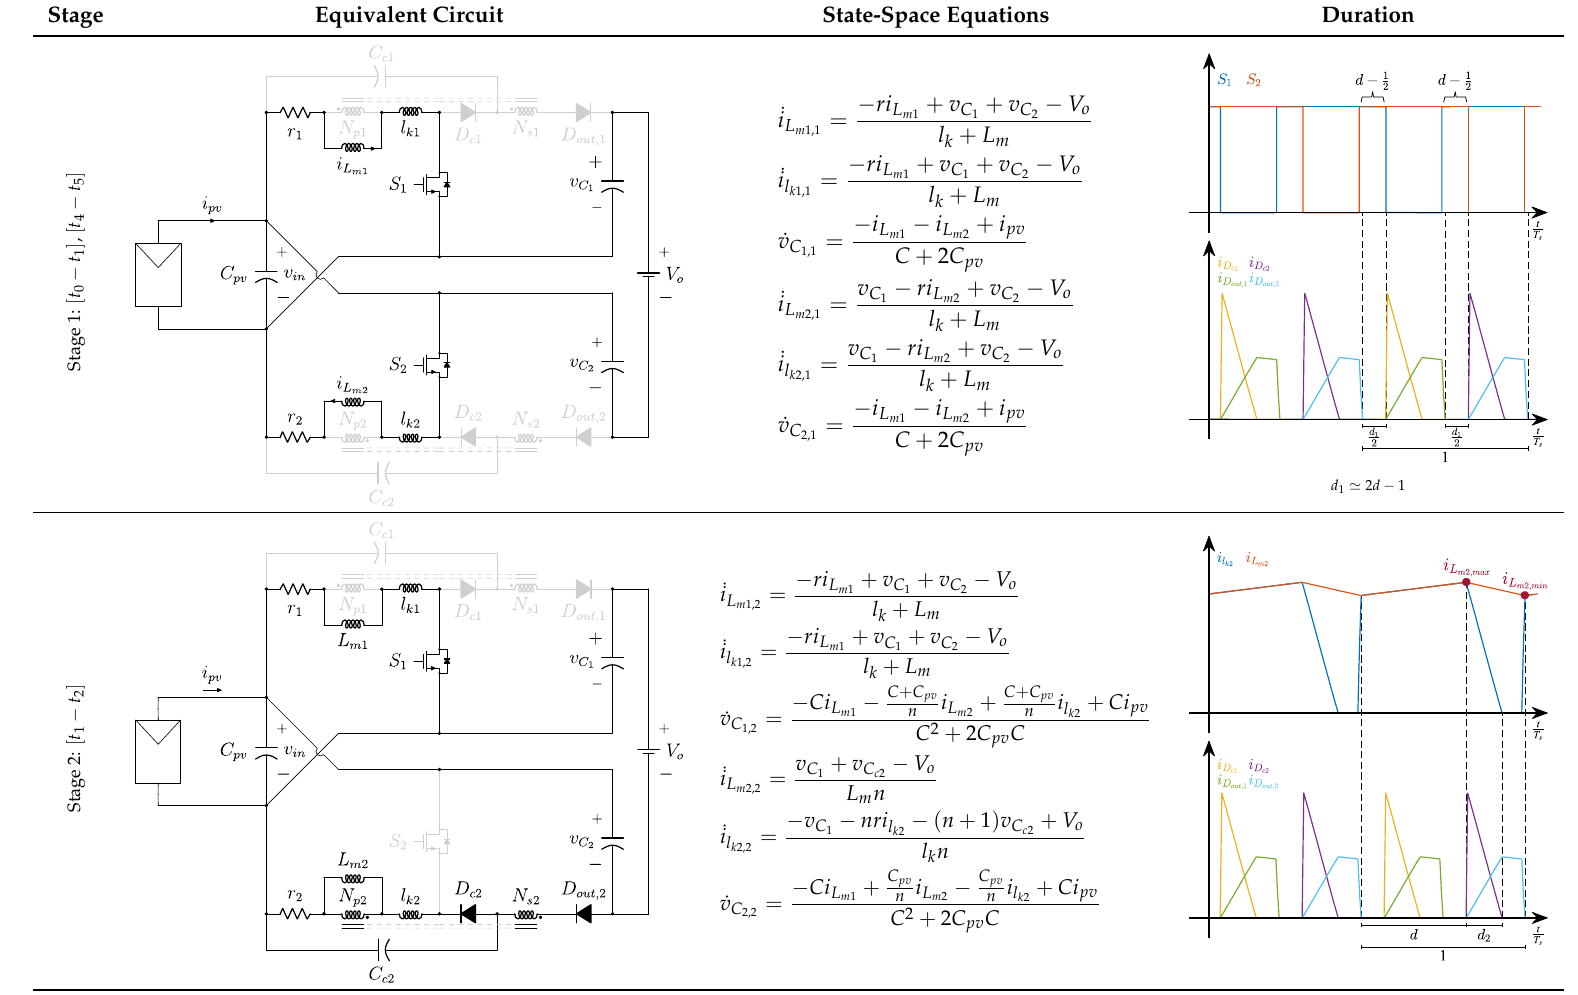
Table 1. Operation